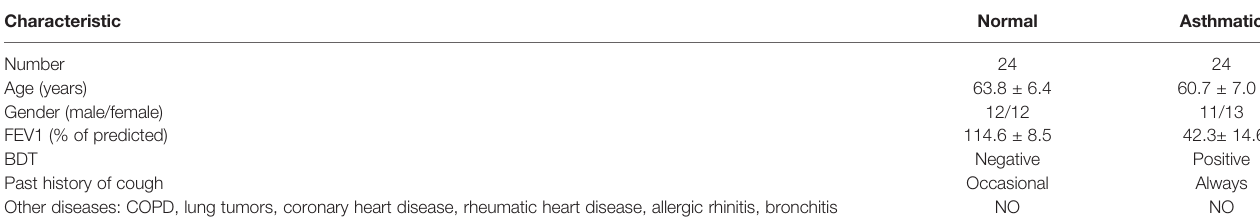
TABLE 1 | Characteristics and physiologies of asthmatic patients and the normal.